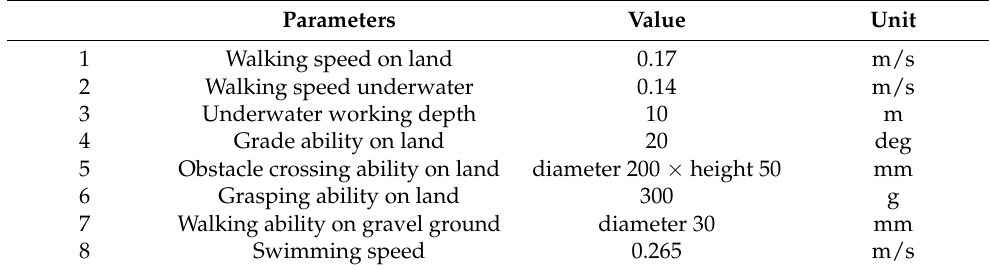
Table 4. The motion performance indexes of the